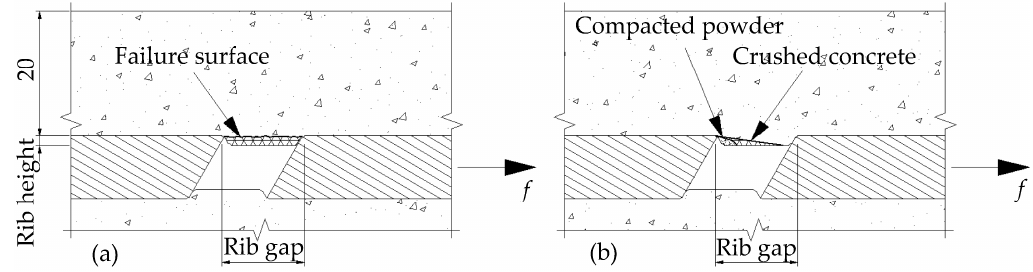
Figure 6. Failure mechanisms. ( a ) Failure of surface; ( b ) Concrete crushing.